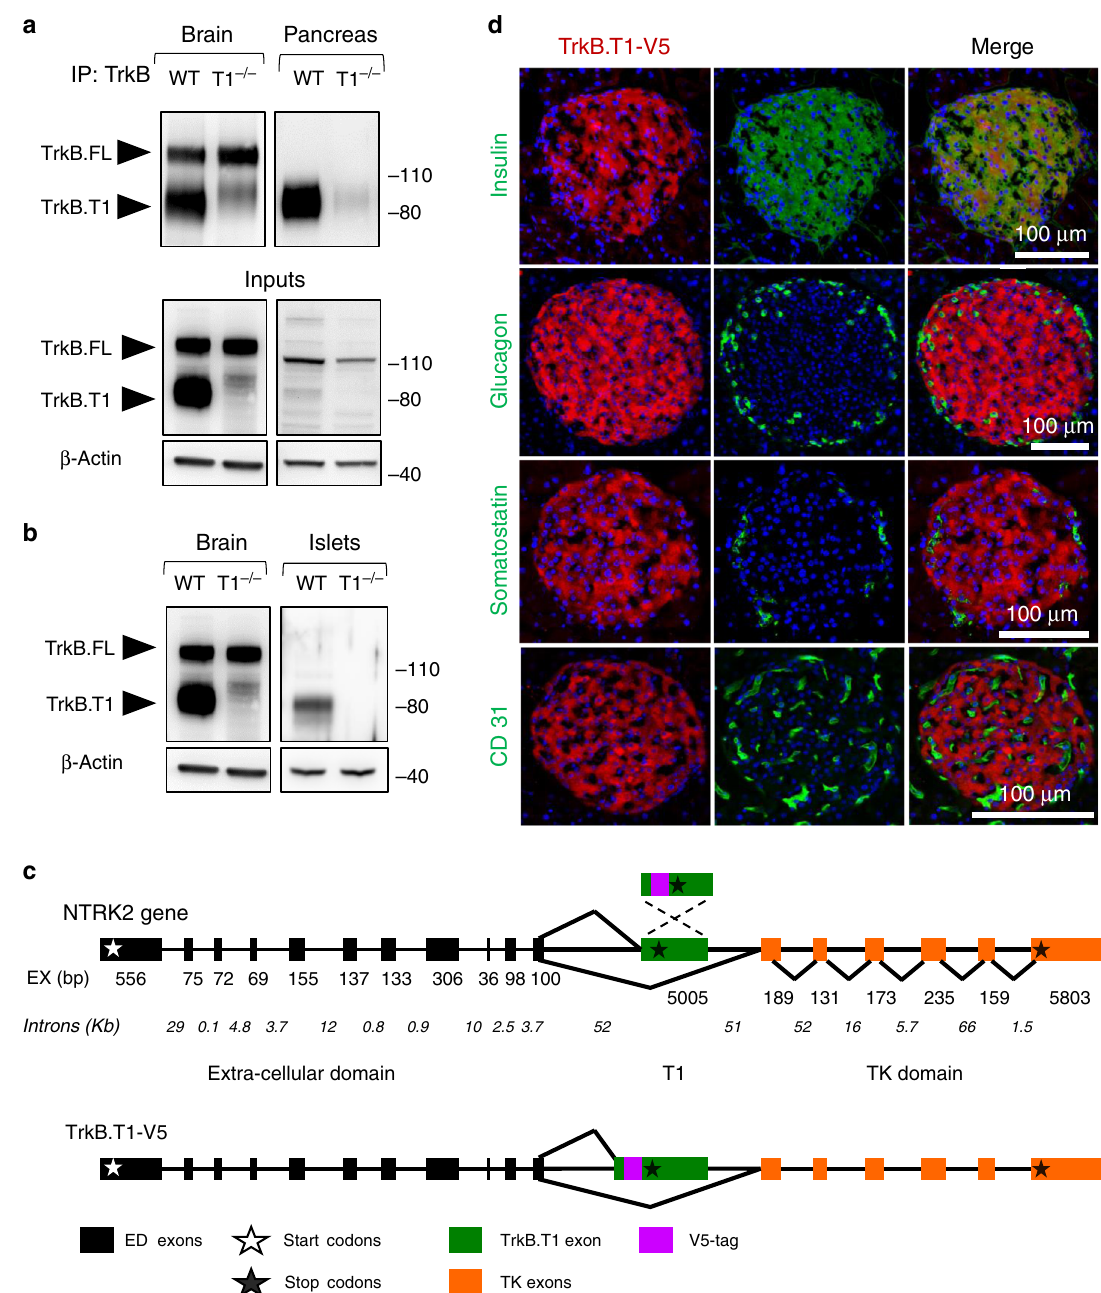
Fig. 1 TrkB.T1 is expressed in mouse pancreatic β -cells. a , b Western blot analysis of whole mouse pancreas protein lysates immunoprecipitated with a TrkB antibody ( a ) or straight lysates from isolated islets ( b ) blotted with an antibody against the extracellular domain of TrkB to detect all TrkB receptor isoforms. Note that both whole pancreas and isolated islets, express only detectable levels of TrkB.T1. Brain lysates were used as positive control, and TrkB. T1 knockout lysates (T1 − / − ) were used to con fi rm antibody speci fi city. On the right is the location of molecular weight markers. c Schematic diagram showing the strategy used to tag TrkB.T1 with a V5 epitope to study TrkB.T1 expression in mouse. d Immuno fl uorescent localization of V5-tagged TrkB.T1 in pancreatic islets. Immunostaining for insulin, glucagon, somatostatin and the endothelial marker CD31 shows exclusive TrkB.T1-V5 expression in β -cells. Source data are provided as a Source Data fi insulin tolerance test (Fig. 2e, f), these data suggest that TrkB. T1 signaling is essential for normal glucose metabolism.